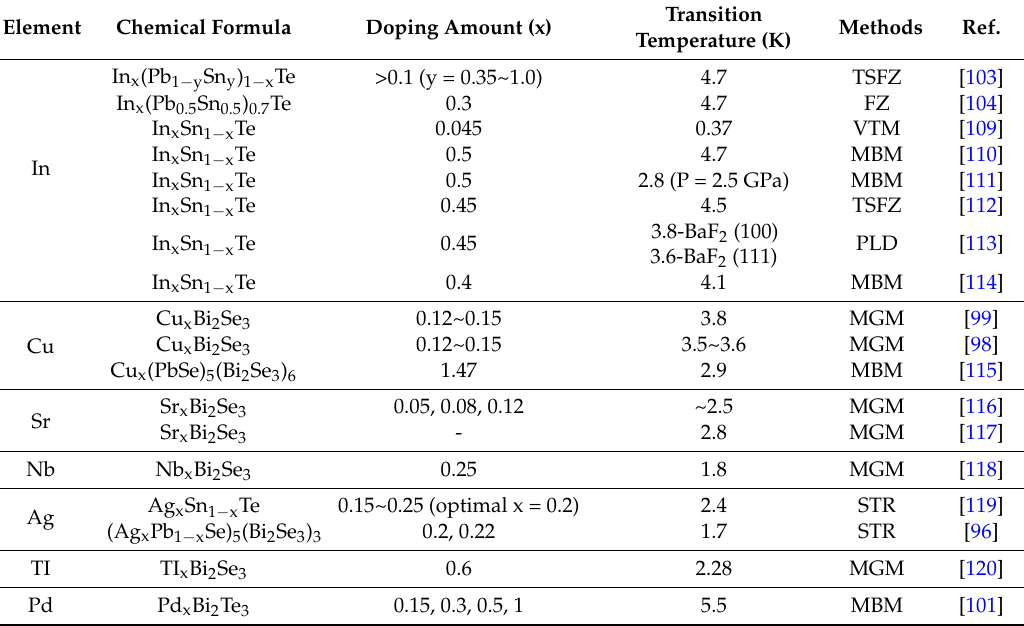
Table 3. Superconductivity of different impurity-doped